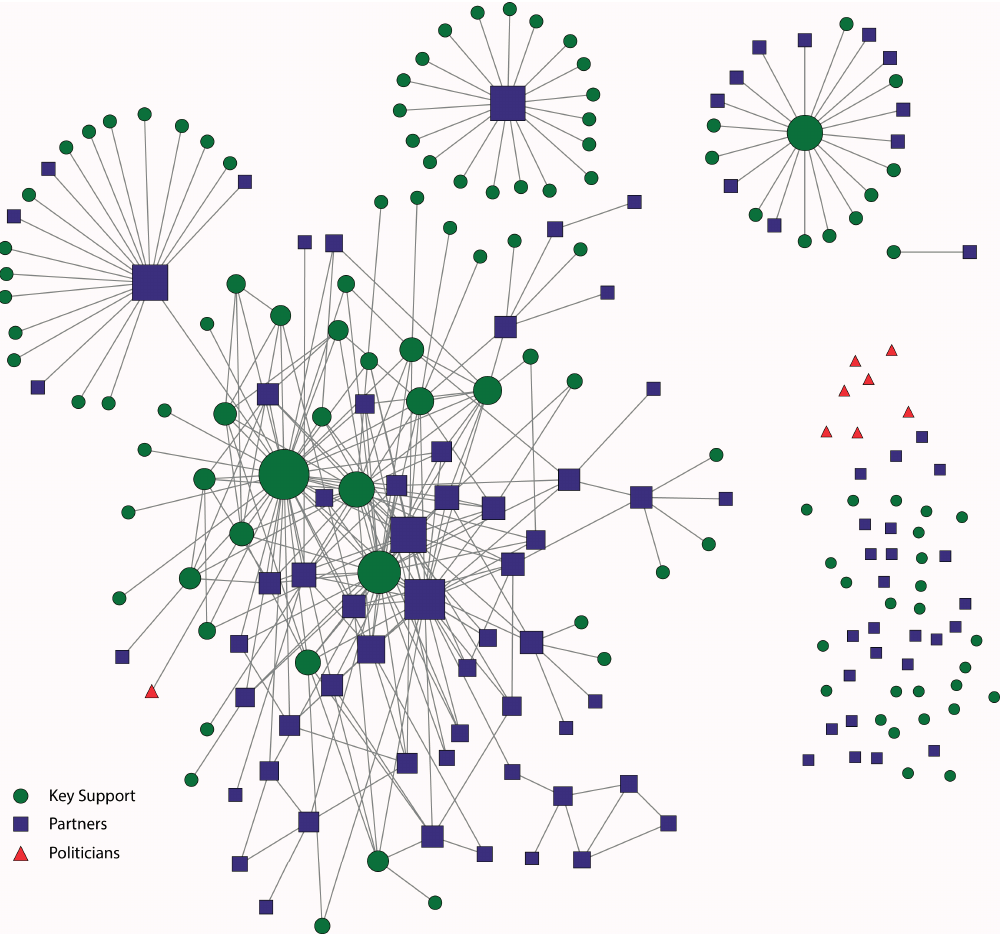
Figure 4. St. Louis Smokefree Policy Contact network. Nodes were sized according to the number of individuals they had contact